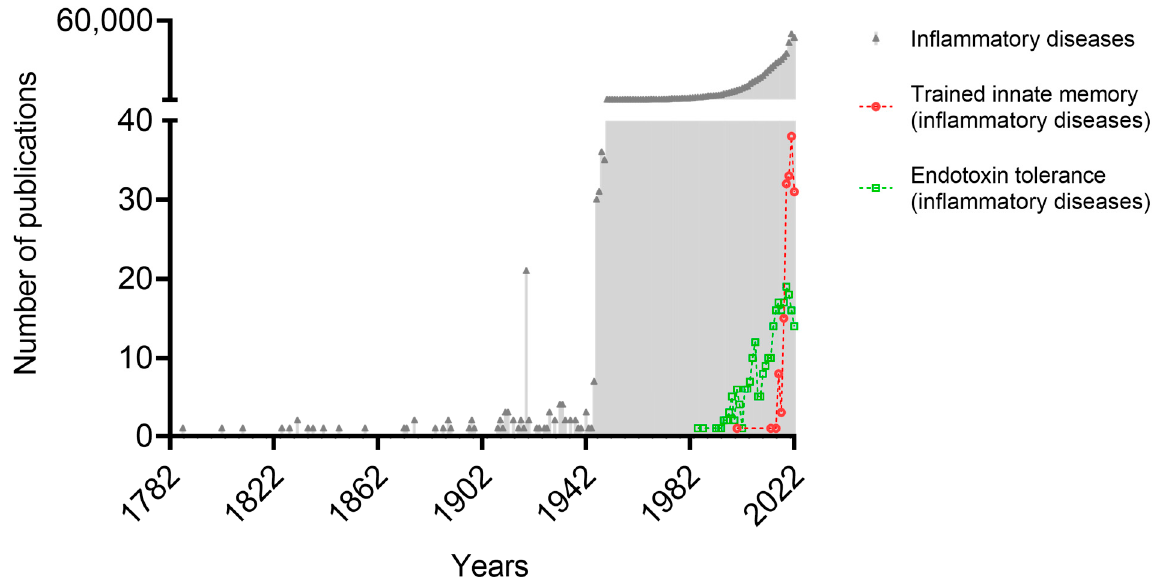
Figure 4. A timeline of the increasing number of publications related to the induction of trained immunity and endotoxin tolerance in various inflammatory disorders. Both adaptive inflammatory processes appear to exhibit a crucial role on the suppression or progression of several inflammatory diseases (PubMed, January 2023).